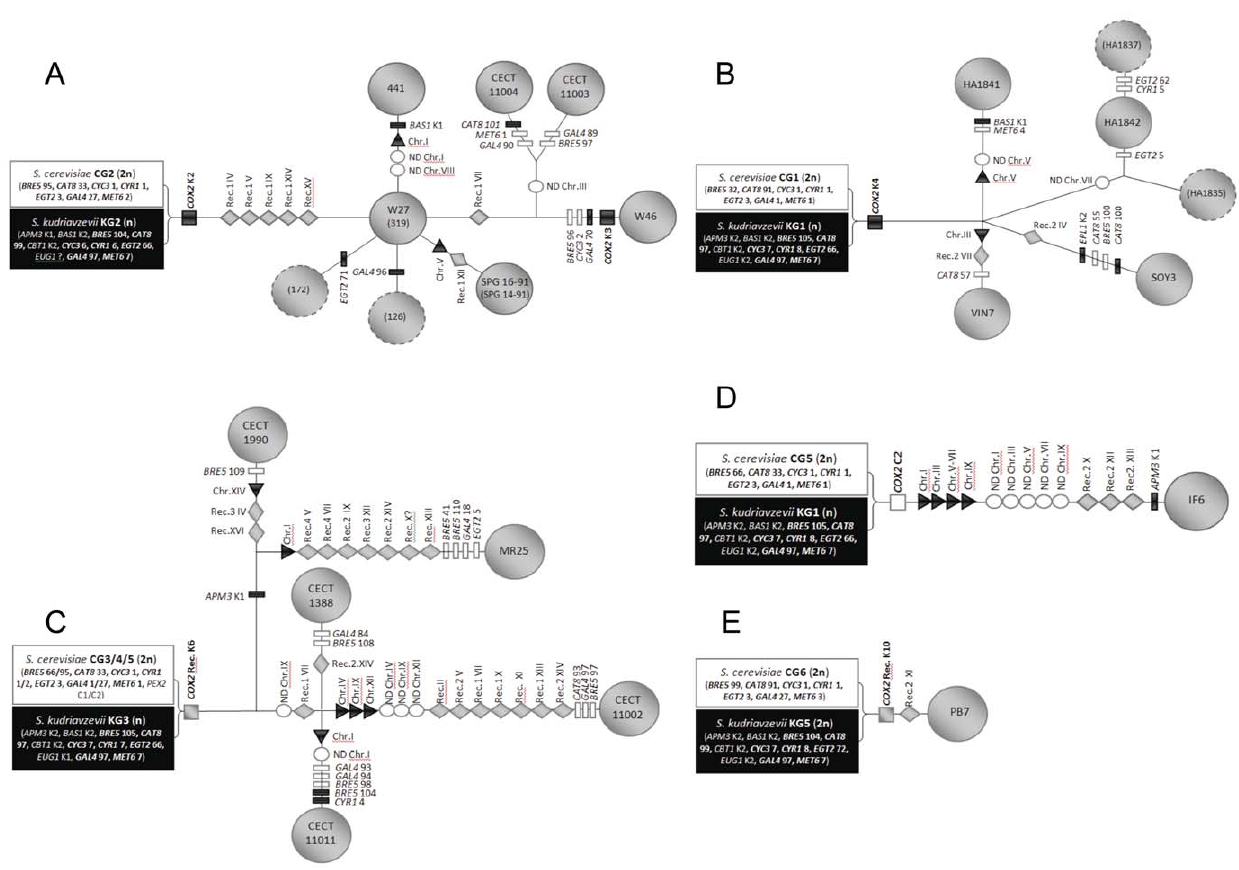
Figure 4. Possible multiple origins for hybrid strains based on Supernetworks, Polymorphic sites (Figure S1), Parsimony (Figure S2) and Neighbor-Joining (Figure S3) gene trees, PCR-RFLP data [ 16,17 ] , COX2 sequence data [ 17 ] and maximum parsimony analysis of chromosome rearrangements [ 32 ] . Five out of six hybridization events are depicted in this figure, AMH and tripe hybrid origins have not been depicted due because they involved secondary hybridization events, in the case of AMH with another S. cerevisiae strain. The putative genetic backgrounds of the parental strains are indicated by squares on the left of each network. Symbols: triangles correspond to chromosome loss; squares to mitochondrial COX2 haplotypes; diamonds to chromosome recombination events; rectangles to mutations generating new allele variants; circles to chromosome non-disjunctions. Those depicted in white are referring to events occurring in the S. cerevisiae subgenome of hybrids; in black, in the S. kudriavzevii subgenome; and in grey, those events involving both subgenomes (recombination events).